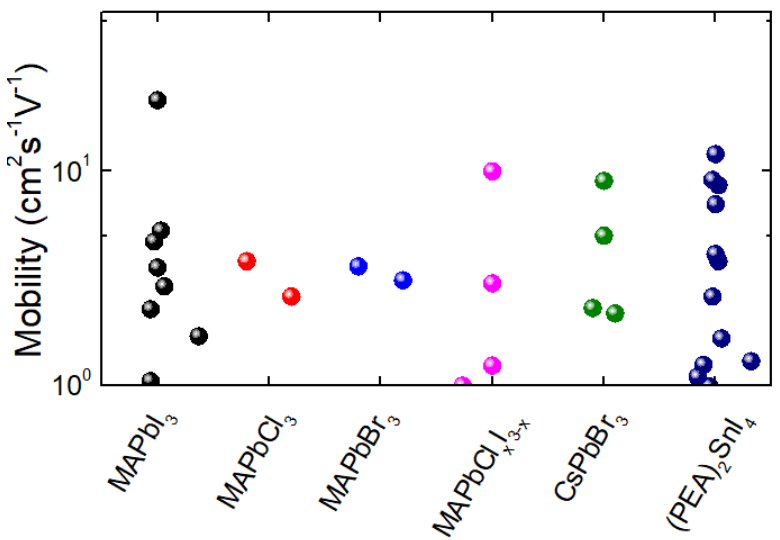
Figure 14. Distribution of hole mobility of various perovskite materials studied using FET struc-